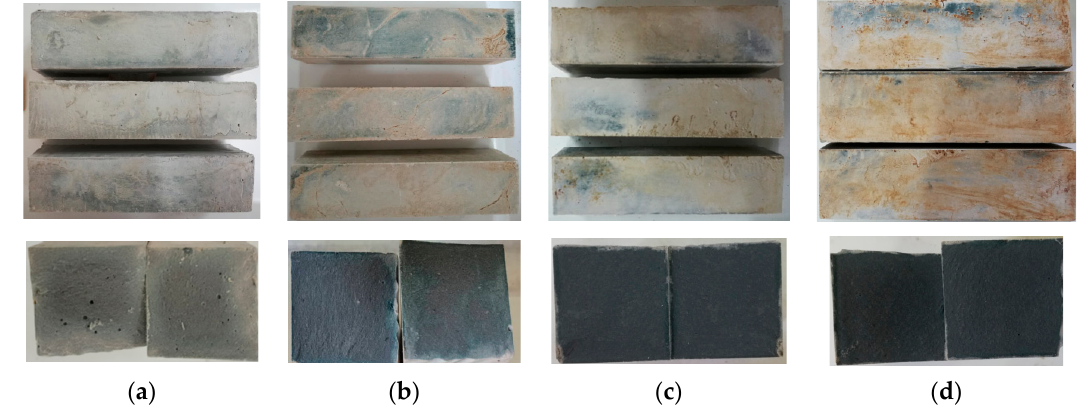
Figure 1. SH geopolymer and cross section ( a ) SH3, ( b ) SH8, ( c ) SH13, ( d ) SH18.